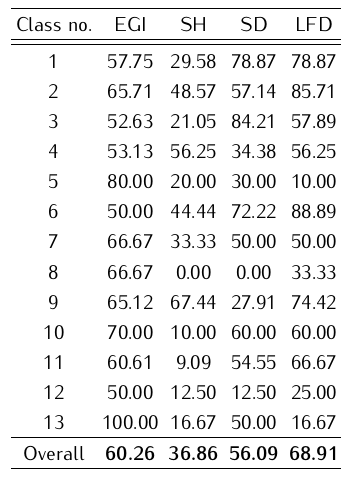
Table 1. The experimental results - retrieval rate for particular 3D shape descriptors investigated during the